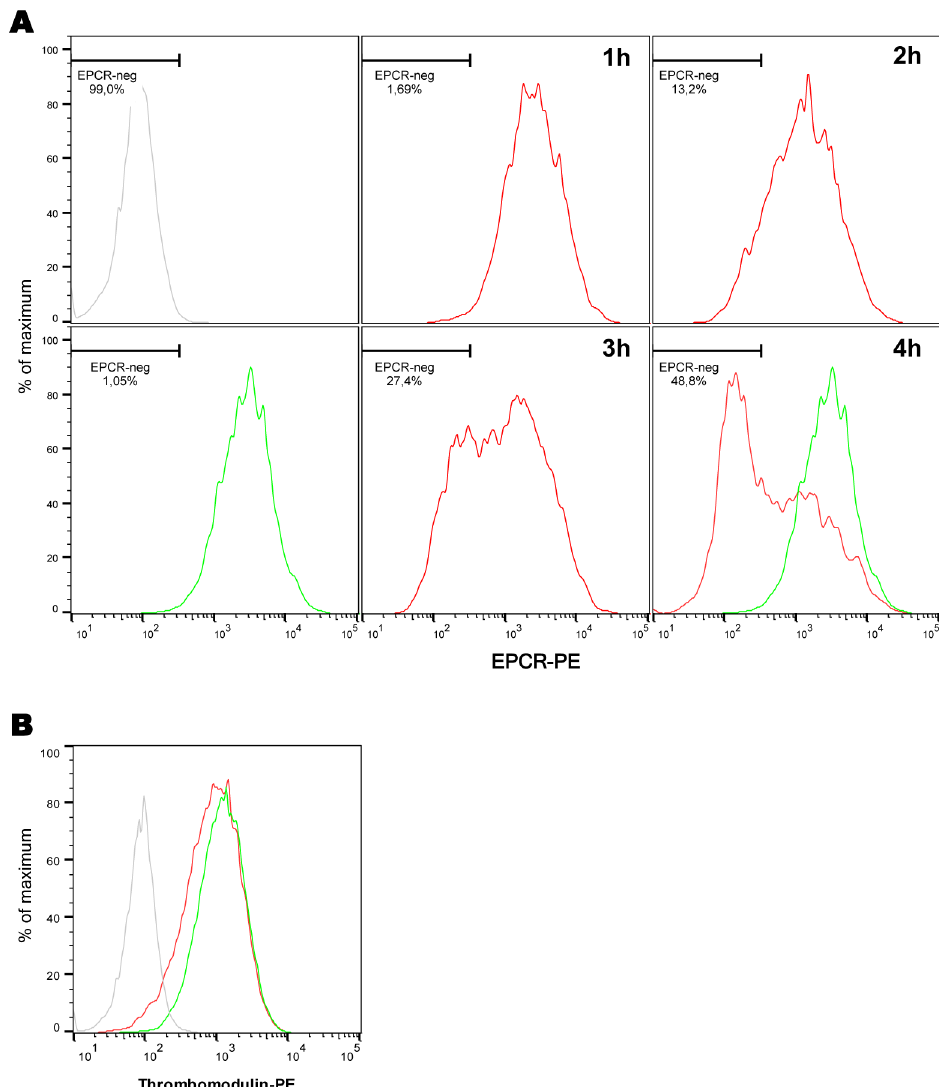
Fig 1. Expression of EPCR and thrombomodulin by endothelial cells after infection by N . meningitidis . Human Dermal Microvessels Endothelial Cells (HDMEC) were infected with a wild-type meningococcus (red) or left non- infected (green). Grey: isotype control. EPCR or thrombomodulin membranous expression were assessed by a FACS analysis. (A) Time course of EPCR expression during 4 hours of infection. The % of cells with no EPCR staining (EPCR-neg) is also indicated. EPCR-neg population was gated using non-infected cells. For the quantification of EPCR expression see supplemental data S1 Fig . (B) Thrombomodulin expression after 4 hours of infection. Data are representative of 3 independent